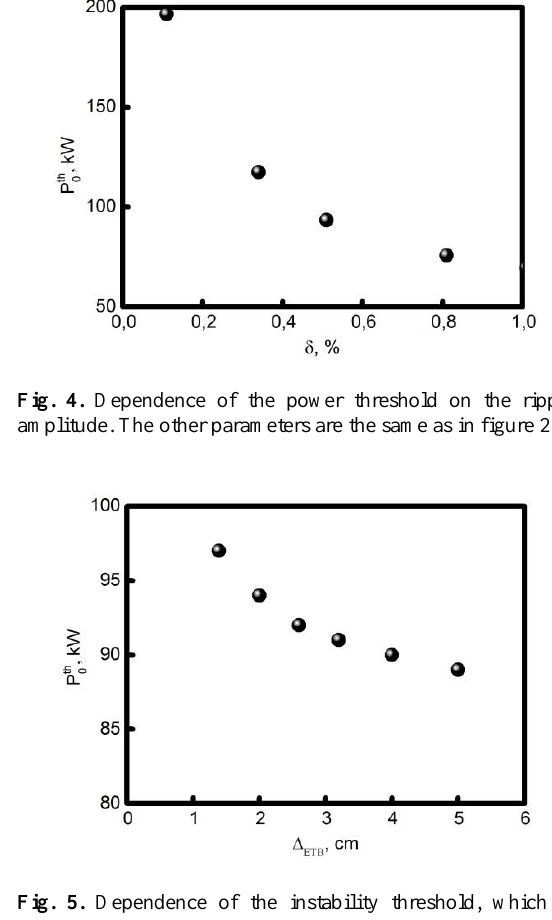
 at ETB q   x and at 1 2.4 cm . ym inf